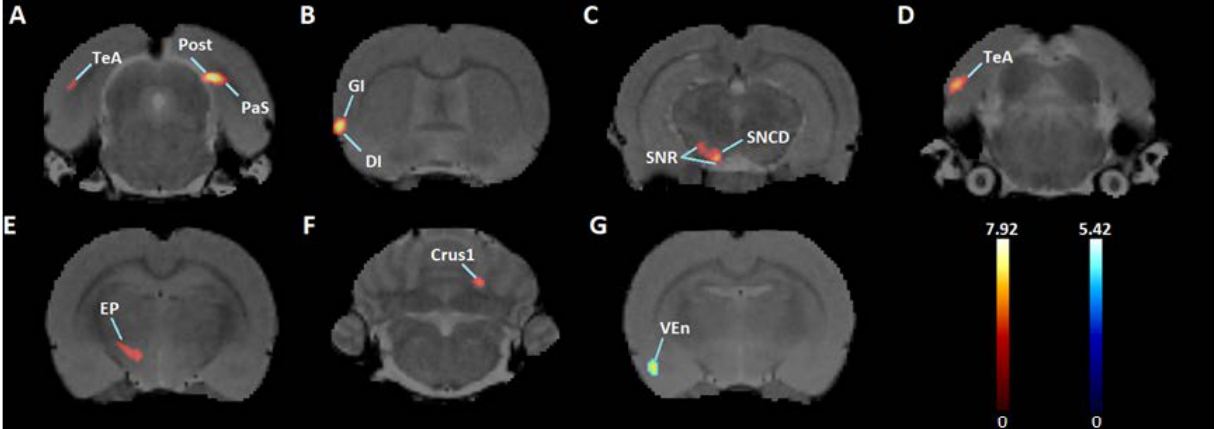
Figure 3. Significant Clusters: Coronal PET images showing brain regions with significant ( p < 0.001, df = 11, and K > 50) metabolic activation ( A – F ) and inhibition ( G ) in exercised rats compared to sedentary rats. T-values represent peak activation (t = 7.92) and inhibition (t = 5.42). Hot scale clusters illustrate BGluM activation in the ( A ) Post and PaS; ( B ) GI and DI; ( C ) SNR and SNCD; ( D ) TeA; ( E ) EP; and ( F ) crus 1. Cold scale clusters represent inhibition, or a decrease in BGluM, in the ( G ) VEn. Table 1. Brain regions with significant metabolic activity changes in exercised rats after an acute cocaine dose ( p < 0.001 df = 11, K > 50). Cluster location is indicated by coordinates in stereotaxic space (medial–lateral, anterior–posterior, and dorsal–ventral). The t-values and z-scores were calculated from the average BGluM of all voxels within the significant clusters. KE represents the number of voxels in the respective cluster. Each cell under “Brain Region(s)” represents a separate